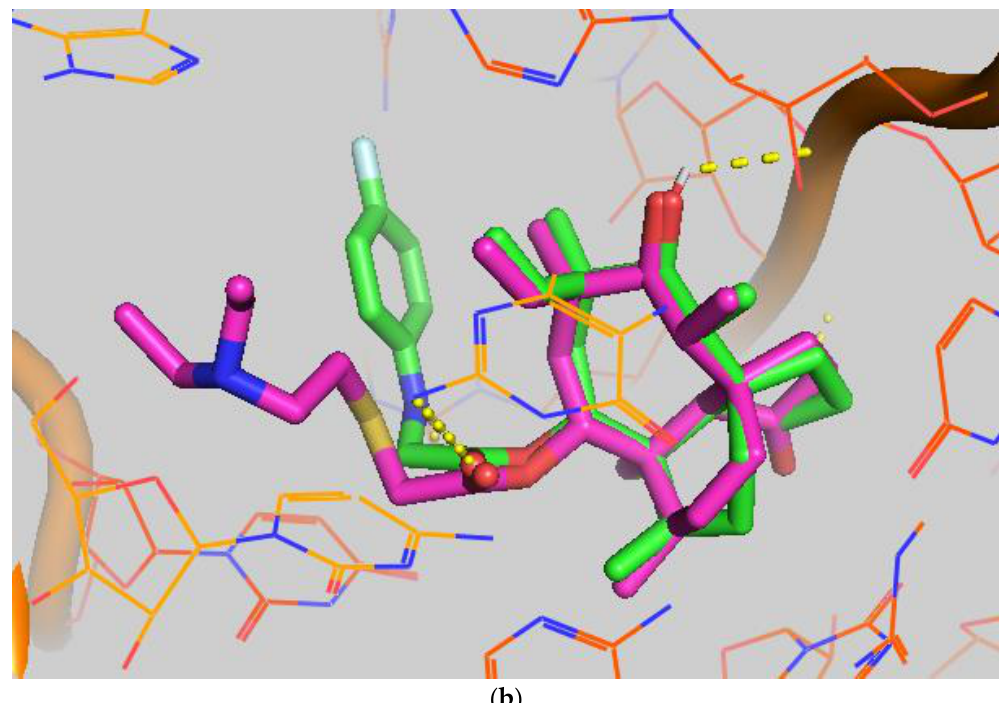
Figure 4. ( a ) The simulated docking modes of compounds 9 (green) to 1XBP; ( b ) the simulated docking modes of compounds 9 (green) and tiamulin (purple) to 1XBP. (Software: AutoDock Vina).